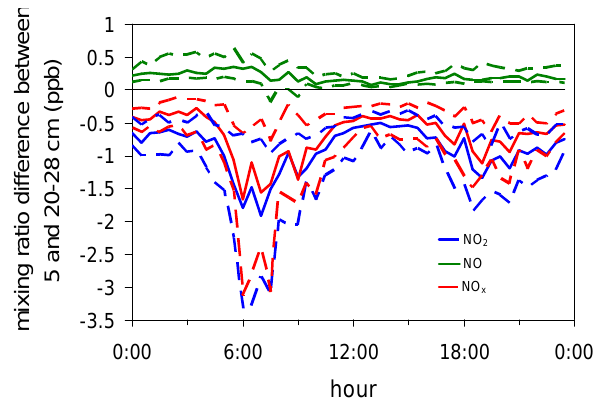
Fig. 8. Mean diurnal cycle of in-canopy mixing ratio differences Figure 8: Mean diurnal cycle of in-canopy mixing ratio differences for NO, NO 2 , and O 3 2 for NO, NO 2 , and O 3 between 5cm and 20–28cm (increasing between 5 cm and 20-28 cm (increasing canopy top) above ground. Solid lines show median 3 canopy top) above ground. Solid lines show median values and dashed lines the interquartile range, respectively, for the entire values and dashes lines the interquartile range, respectively, for the entire measurement 4 measurement period. period. 5